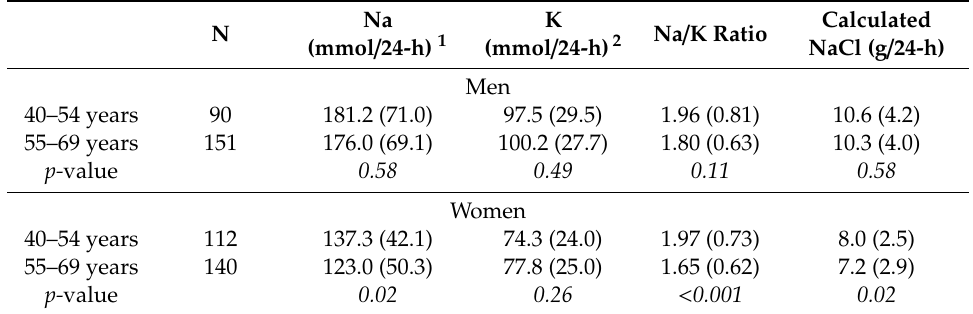
Table 2. Sodium (Na), potassium (K), and sodium to potassium ratio (Na / K ratio) in 24-h urine by age groups in men and women participating in the seventh wave of the Tromsø Study ( n = 493), mean and standard deviation.